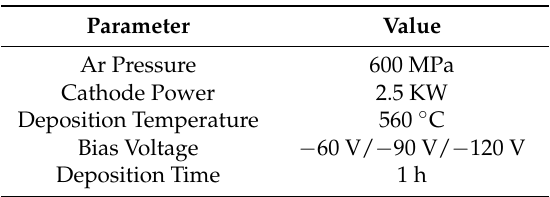
Table 1. Deposition parameters of Cr-Al-C